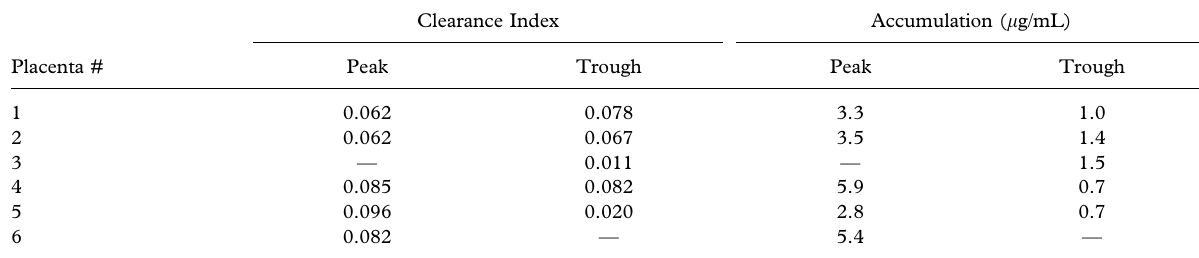
Table II. Meropenem clearance index and